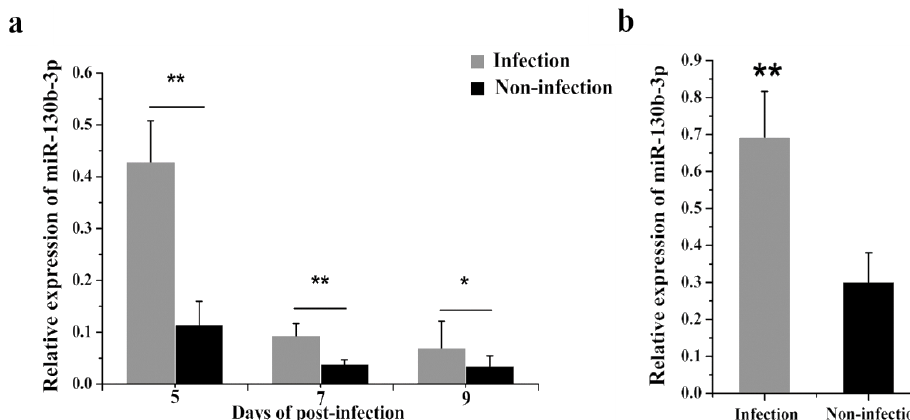
Figure 1. miR-130b-3p was highly expressed in both MG -infected chicken embryo lungs and DF-1 cells. ( a ) The relative level of miR-130b-3p in MG -infected chicken embryo lungs. Total RNA were extracted from frozen infected chicken embryo lungs on days 5, 7, and 9 post-infection (equivalent to days 14, 16, and 18 of eggs hatching) using TRNzol Universal. Then, the level of miR-130b-3p in MG infected embryo chicken lungs was determined through RT-qPCR; ( b ) The relative level of miR-130b-3p in MG- infected DF-1 cells. Cells cultivated in 6-well culture dishes were treated with 200 μL MG (1 × 10 10 CCU/mL). After 24 h treatment, total RNA of infected cells were extracted using TRNzol Universal. The level of miR-130b-3p-infected cells was detected by RT-qPCR. The data was normalized to 5S-rRNA. Each experiment group contained at least three duplicates. Each duplicate was measured at least three times. All values are expressed as mean ± SD. Marked differences were expressed as * p < 0.05, ** p < 0.01.